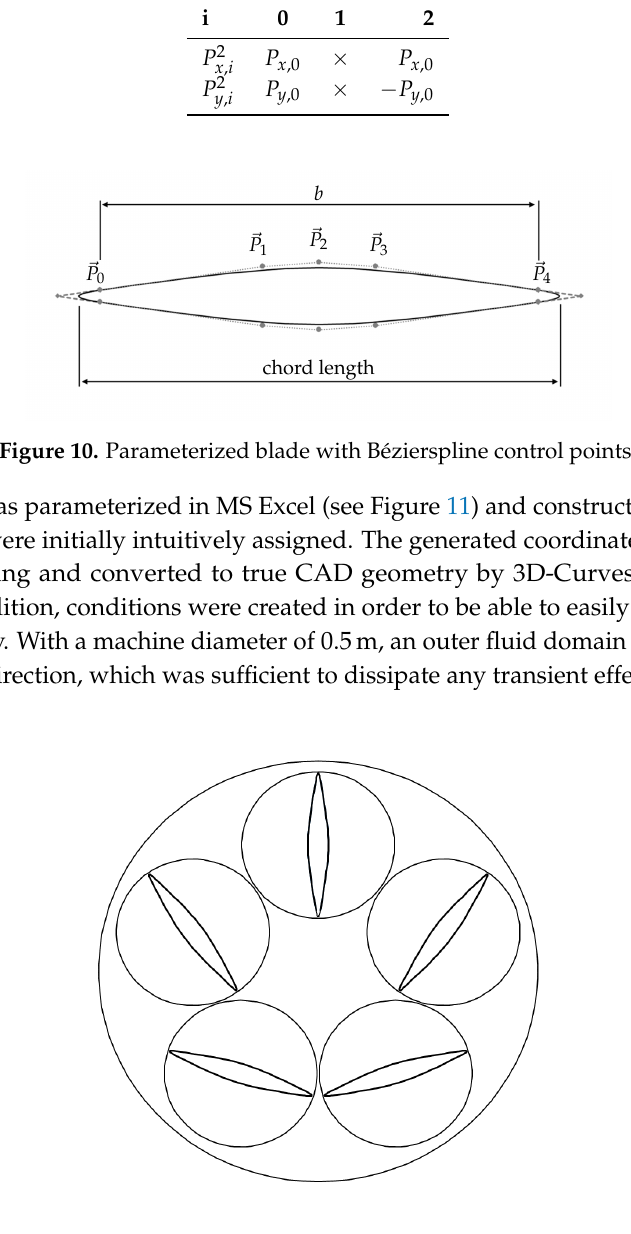
Table 2. Definition of the control points of the left short spline n = 2.